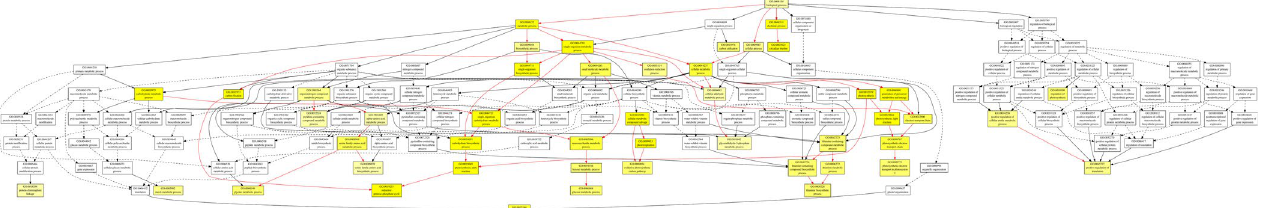
Figure 5. Biological Process (BP) of GO term enrichment for down-regulated common DEGs in A. stolonifera . Yellow color indicates significantly enriched GO terms. The density of color in each node was proportional to statistical significance of enrichment of the corresponding GO term. Red edges stand for relationship between enriched GO